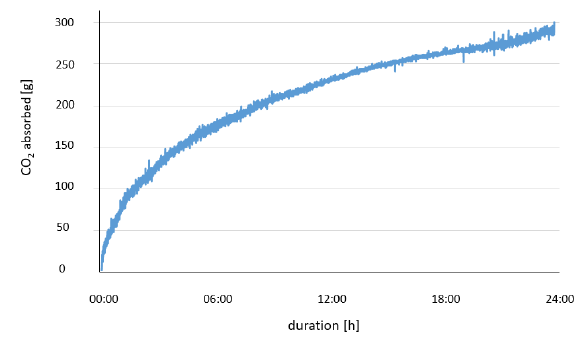
Figure 4. Carbonation results for C25/30, CEM II- B, grain size 8 −